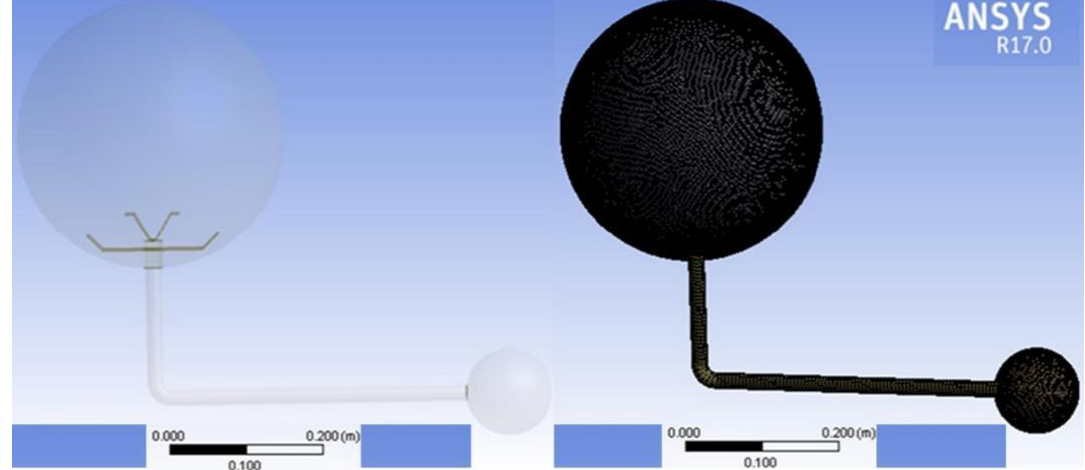
Figure 7. Geometric model and meshing diagram of 20 L spherical explosion container.